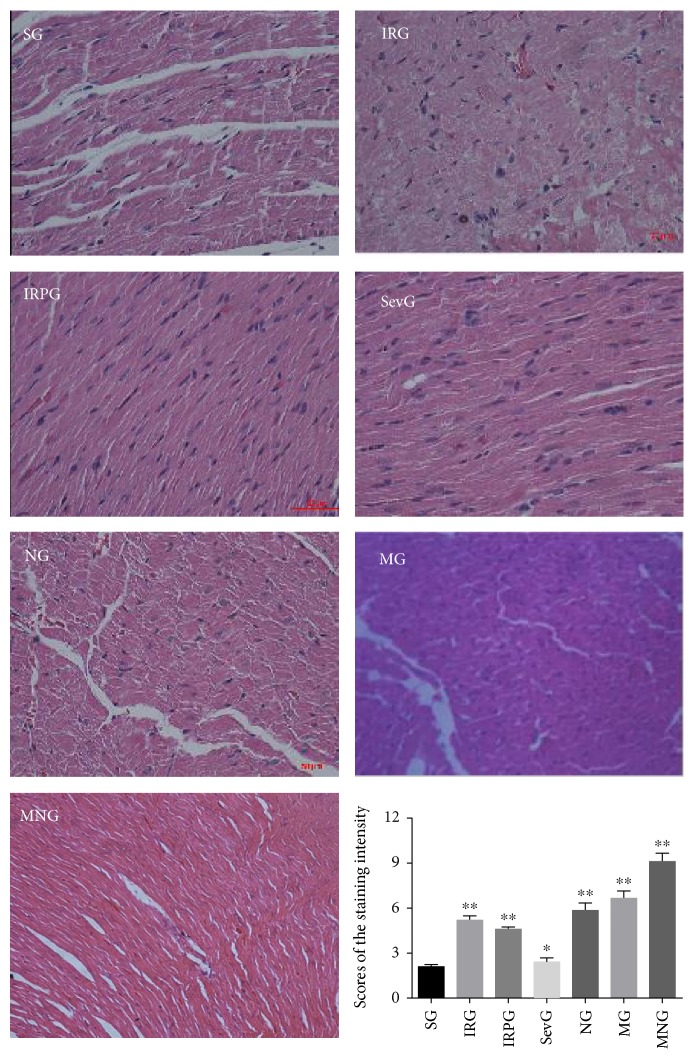
HE staining analysis for cellular morphology in different groups (magnification 400x). The staining intensity was presented as mean values ± S.D. ∗P < 0.05 via SG, n = 7. ∗∗P < 0.01 via SG.